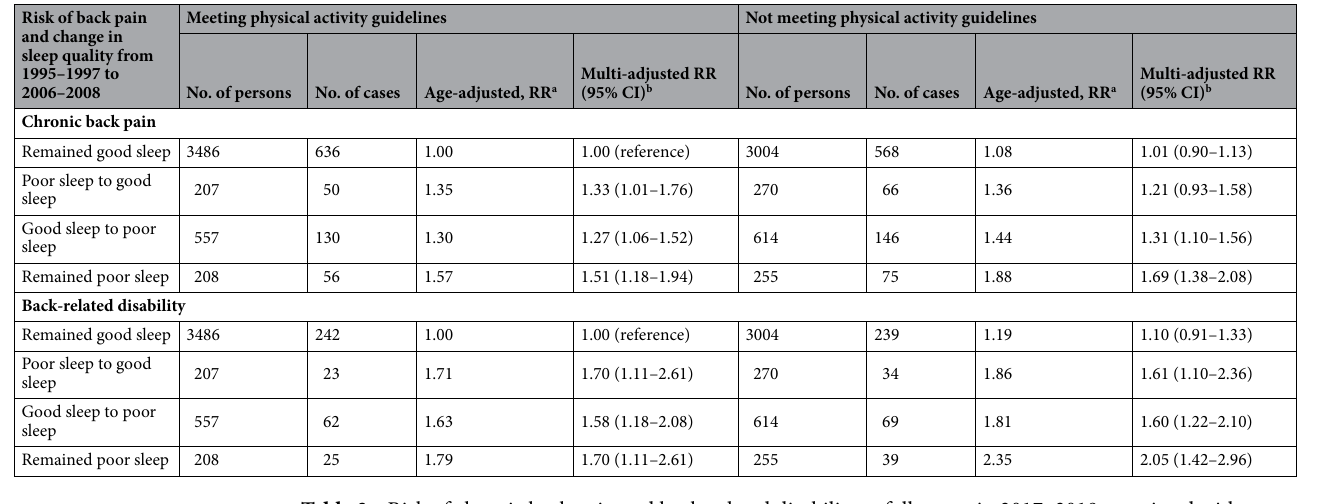
Table 3. Risk of chronic back pain and back-related disability at follow-up in 2017–2019 associated with changes in sleep quality from 1995–1997 to 2006–2008 and adherence to physical activity recommendations in 2006–2008. CI confidence interval, RR risk ratio. a Adjusted for age (continuous). b Adjusted for